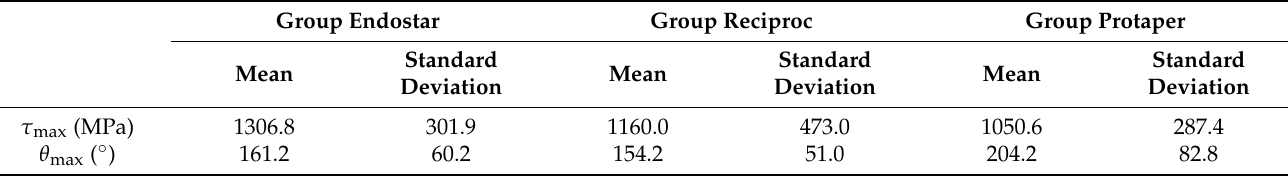
Table 2. Values of the maximum shear stresses τ max and of the twist angle θ max at